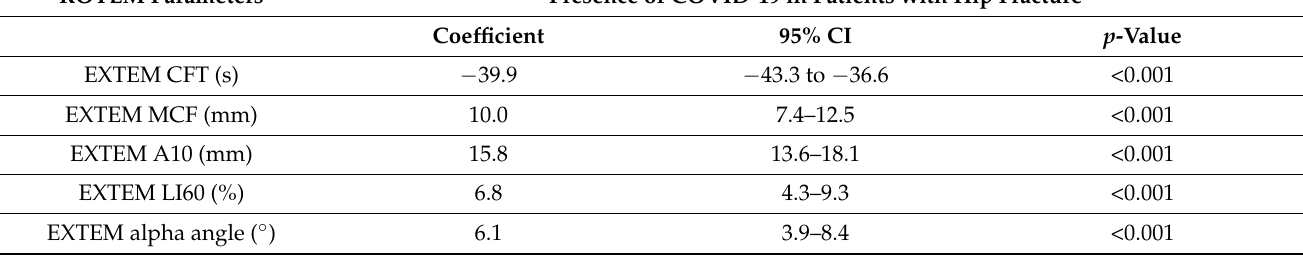
Table 4. Results of multivariable regression analysis for the evaluation of the effect of COVID on the coagulation profile of patients with hip fractures as evaluated by ROTEM parameters, adjusted for age, gender, Charlson Comorbidity Index and Body Mass Index. In the model, presence of COVID-19 disease is used as an independent variable and ROTEM parameters as dependent